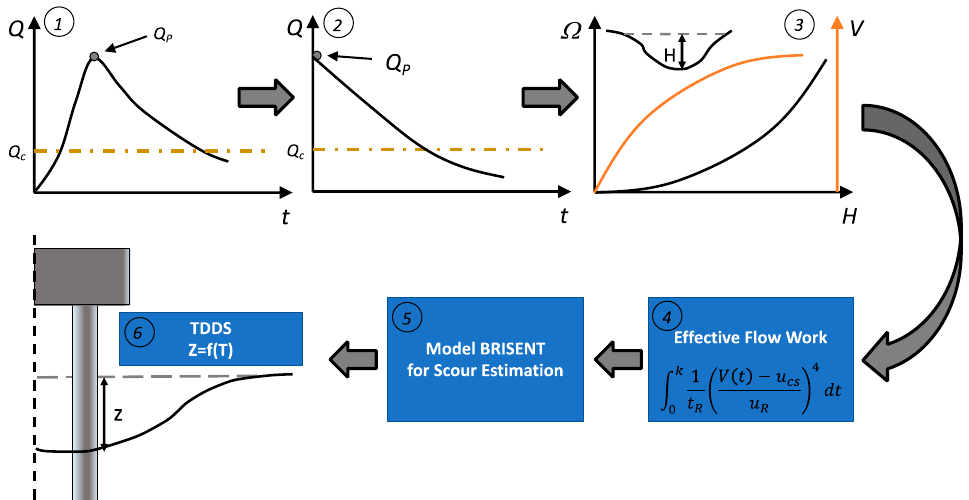
Figure 2. Conceptual diagram illustrating the different steps of TDDS derivation: (1) The natural flood hydrograph; (2) the equivalent exponential hydrograph; (3) the use of the mean flow velocity function to derive the scour energy; (4) estimation of the effective flow work; (5) derivation of the total scour at the event scale; and (6) derivation of the probability distribution of scour.